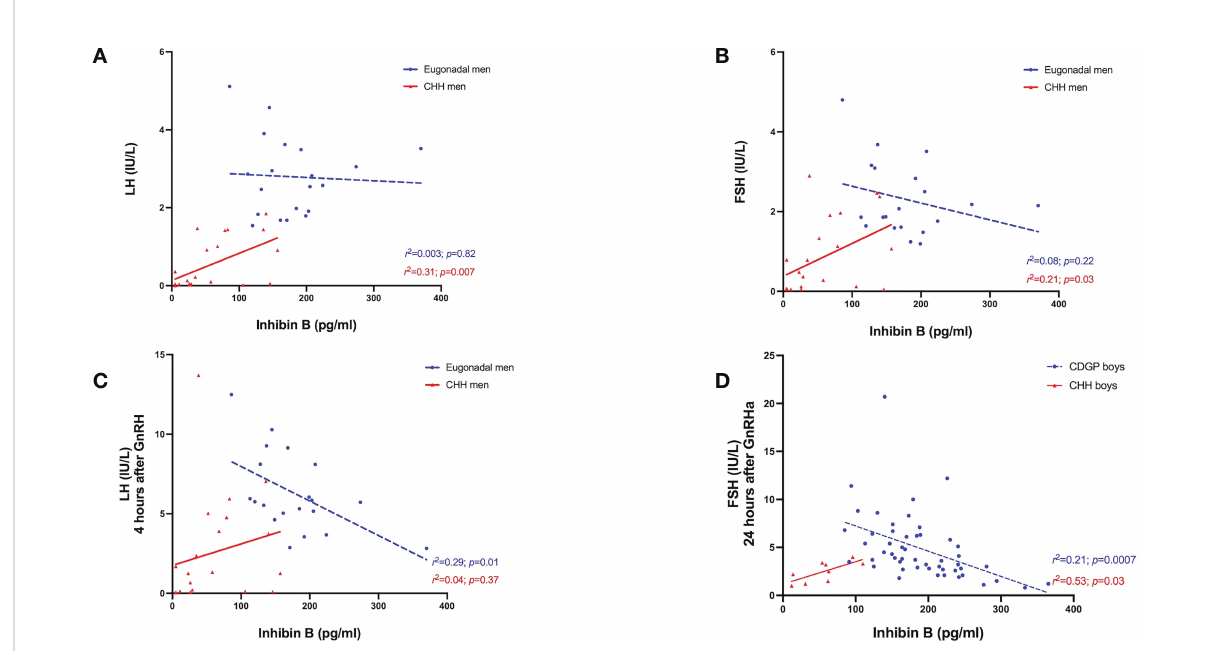
FIGURE 4 (A) Relationship between INB (pg/ml) levels over basal LH (IU/L) in eugonadal men (blue circles) and men with CHH (red triangles). Simple linear regression r 2 = 0.003; p =0.82 in eugonadal men (blue dotted line); r 2 = 0.31; p =0.007 in men with CHH (red solid line). (B) Relationship between INB (pg/ml) levels over basal FSH (IU/L) in eugonadal men (blue circles) and men with CHH (red triangles). Simple linear regression r 2 = 0.08; p =0.22 in eugonadal men (blue dotted line); r 2 = 0.21; p =0.03 in men with CHH (red solid line). (C) Relationship between INB (pg/ml) levels over stimulated LH (IU/L) 4 hours after GnRH in eugonadal men (blue circles) and men with CHH (red triangles). Simple linear regression r 2 = 0.29; p =0.01 in eugonadal men (blue dotted line); r 2 = 0.04; p =0.37 in men with CHH (red solid line). (D) Relationship between INB (pg/ml) levels over stimulated FSH (IU/L) 24 hours after GnRHa in boys with CDGP (blue circles) and boys with CHH (red triangles). Simple linear regression r 2 = 0.21; p =0.0007 in boys with CDGP (blue dotted line); r 2 = 0.53; p =0.03 in boys with CHH (red solid